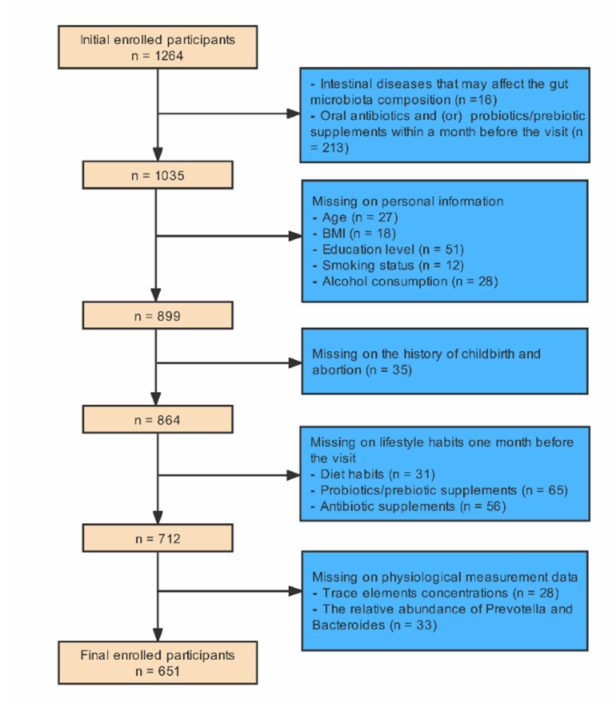
Figure 1. The exclusion procedure of study